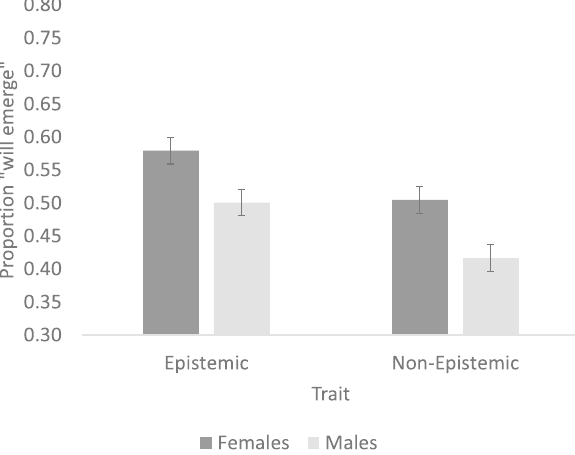
Figure 3. The perceived likelihood that psychological traits will emerge in the afterlife. Error bars are standard error of the means (computed over the subjects’